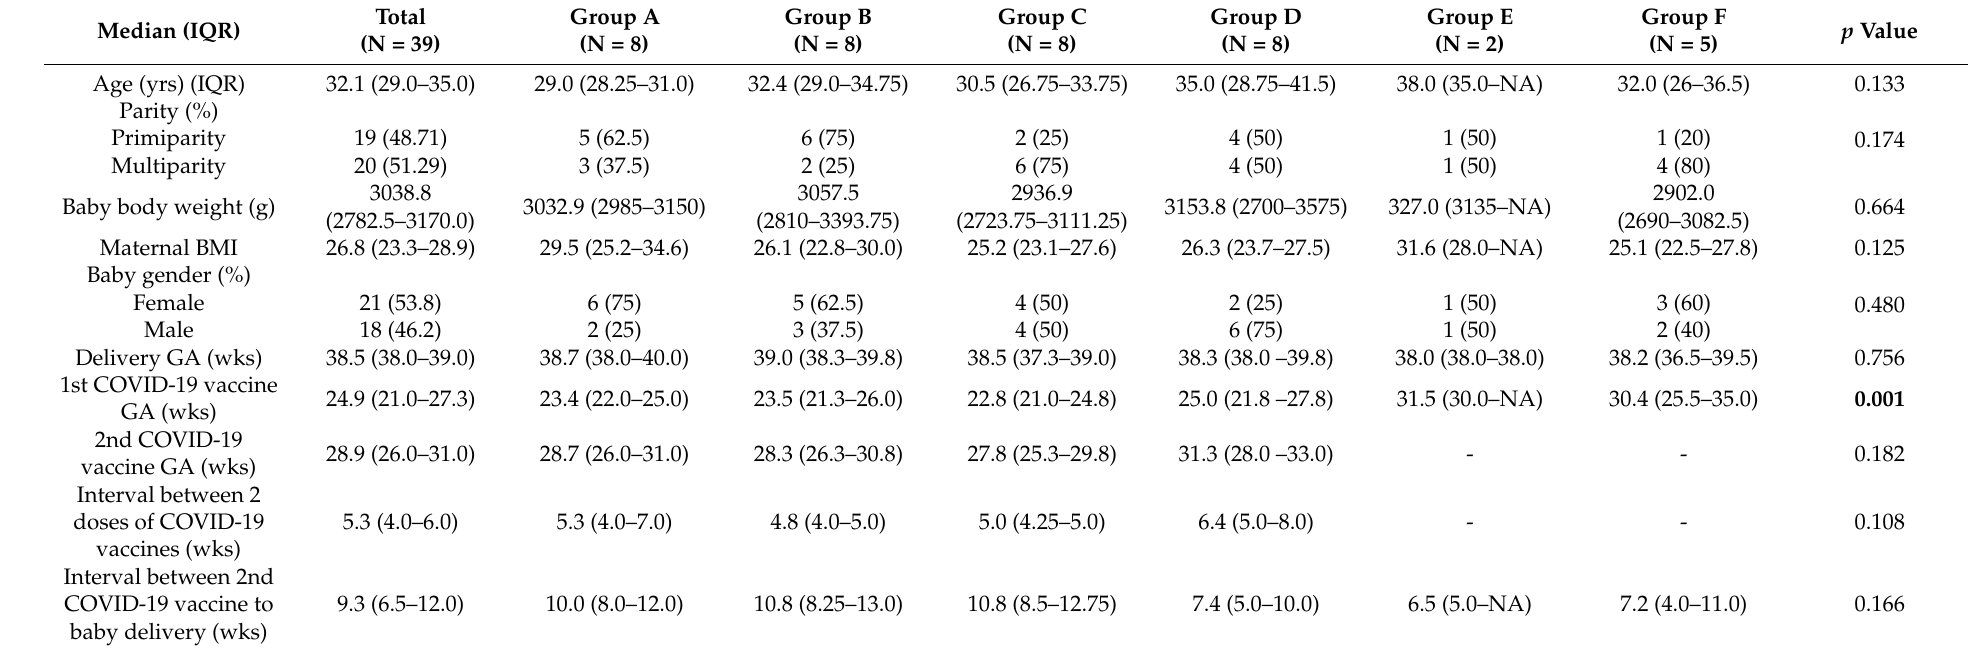
Table 1. Patient